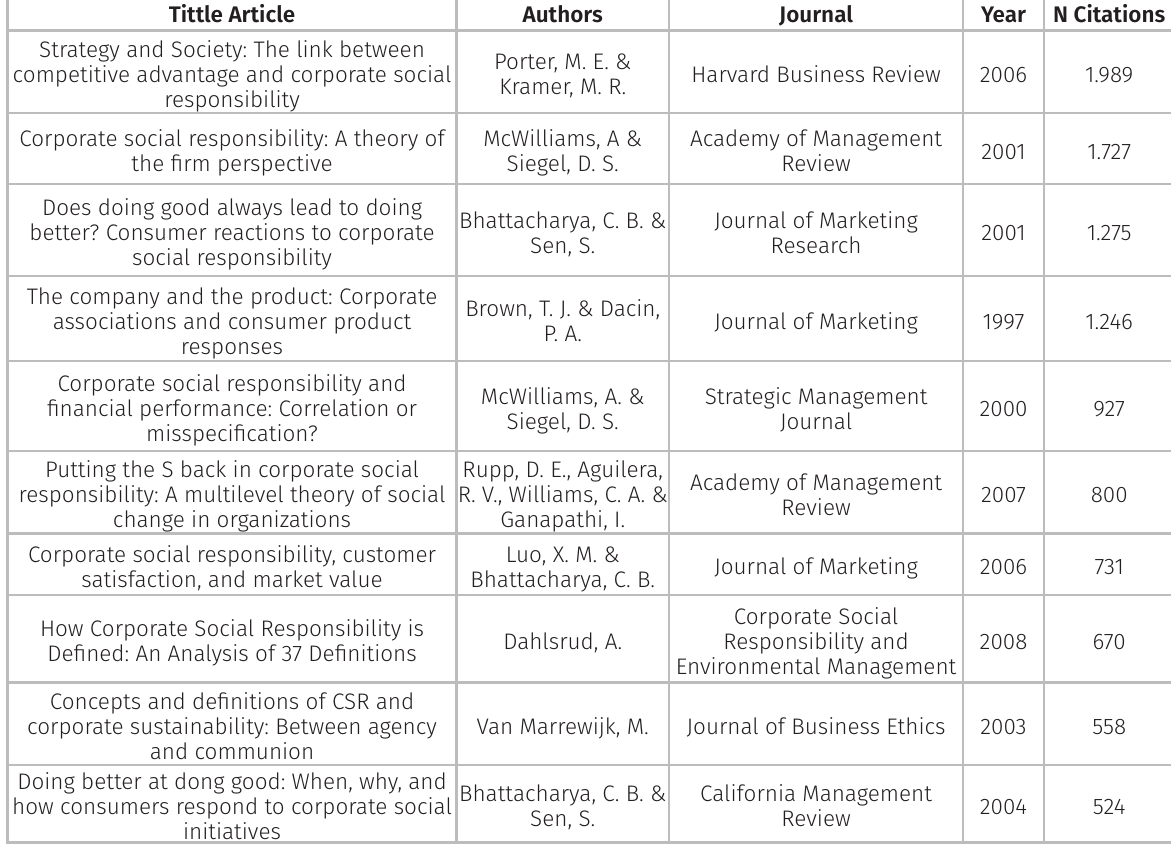
Table II. Most cited articles in Corporate Social